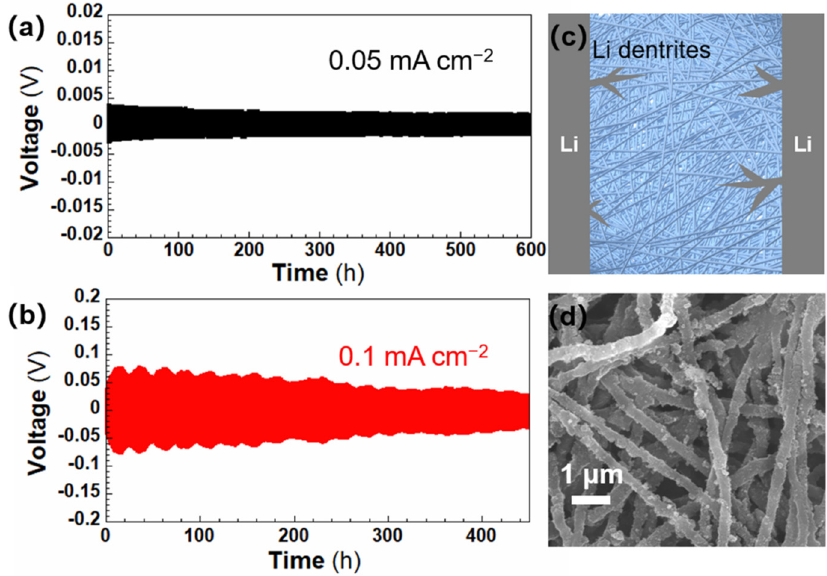
Figure 4. Potential profiles for Li plating/striping test as a function of time cycled at current density of ( a ) 0.05 mA cm − 2 and ( b ) 0.1 mA cm − 2 for the Li|PAN@PSiO|Li symmetric cell, ( c ) the schematic diagram of Li dendrites growth inside the PAN@PSiO membrane and ( d ) the SEM image of the PAN@PSiO membrane after the galvanostatic cycling tests.